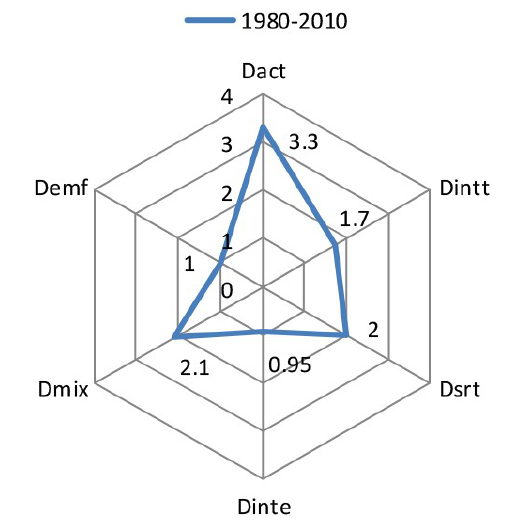
Figure 6. Radar chart for CO 2 emission decomposition in 1980-2010